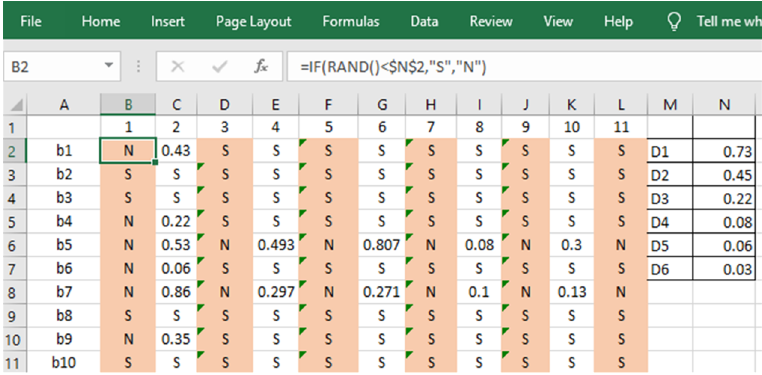
Figure 3. Formula used in column B of Excel sheet.